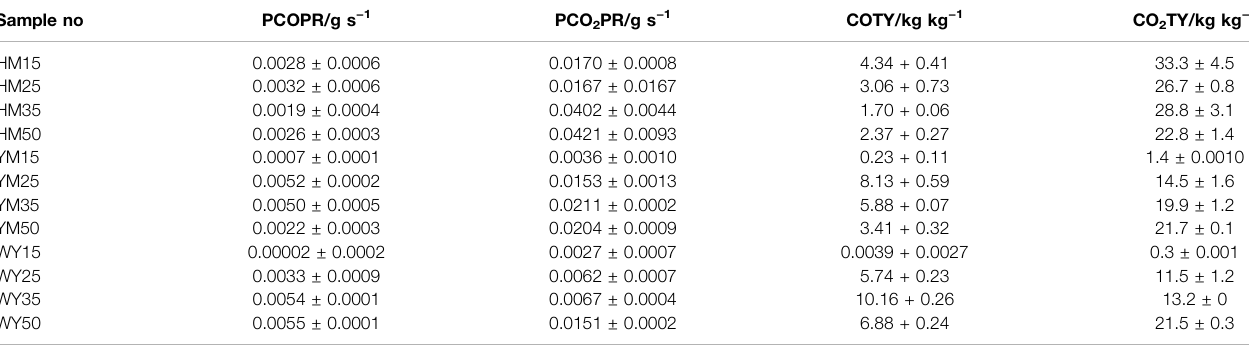
TABLE 5 | The related CO and CO 2 release data of coal